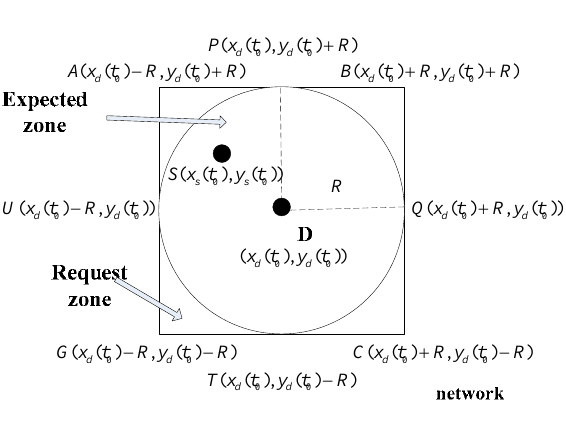
Fig. 1. Source node outside the expected zone